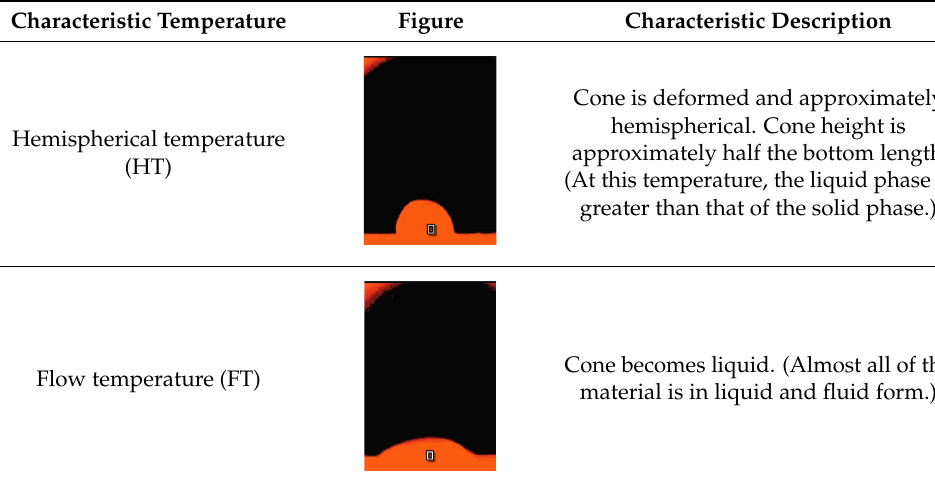
Flow temperature (FT)